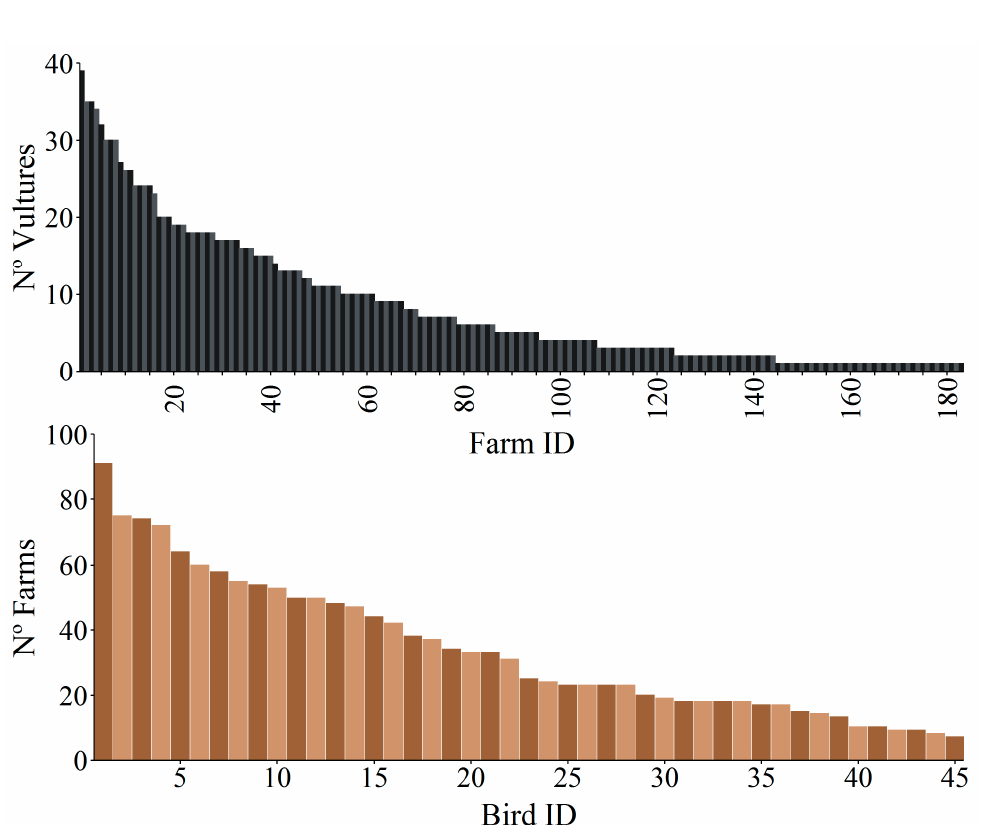
Figure 3. Frequency distribution of ( top ) the number of vultures that visited each farm ( Farm ID ) during the whole study period and ( bottom ) the number of farms that were visited by each tagged vulture ( Bird ID ) during the whole study period. There were 77 farms not visited by vultures that were not included in the figure.